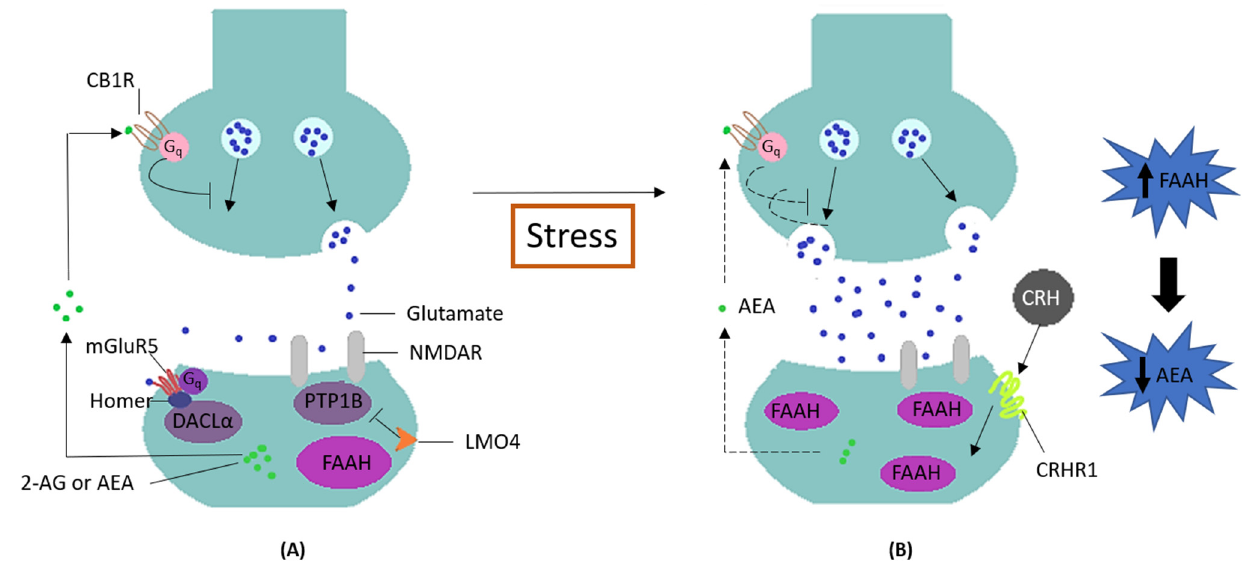
Figure 1. Endocannabinoid system as regulator of stress response. Under normal circumstances ( A ), the endocannabinoid system suppresses the release of the neurotransmitter glutamate via AEA, modulating the synaptic function. However, acute stress ( B ) can trigger a mechanism mediated by CRH and its receptor CRHR1, which is known to increase FAAH activity in the basolateral amygdala. As a result, there is a decrease in AEA levels, which is no longer able to suppress glutamate release. Consequently, increased neural excitability in the basolateral amygdala promotes anxiety- like behavior (adapted by Lutz et al.) [41]. CB1R: cannabinoid type 1 receptor; Gq: family G protein; mGluR5: metabotropic glutamate receptor 5; AEA: N-arachidonoylethanolamine;